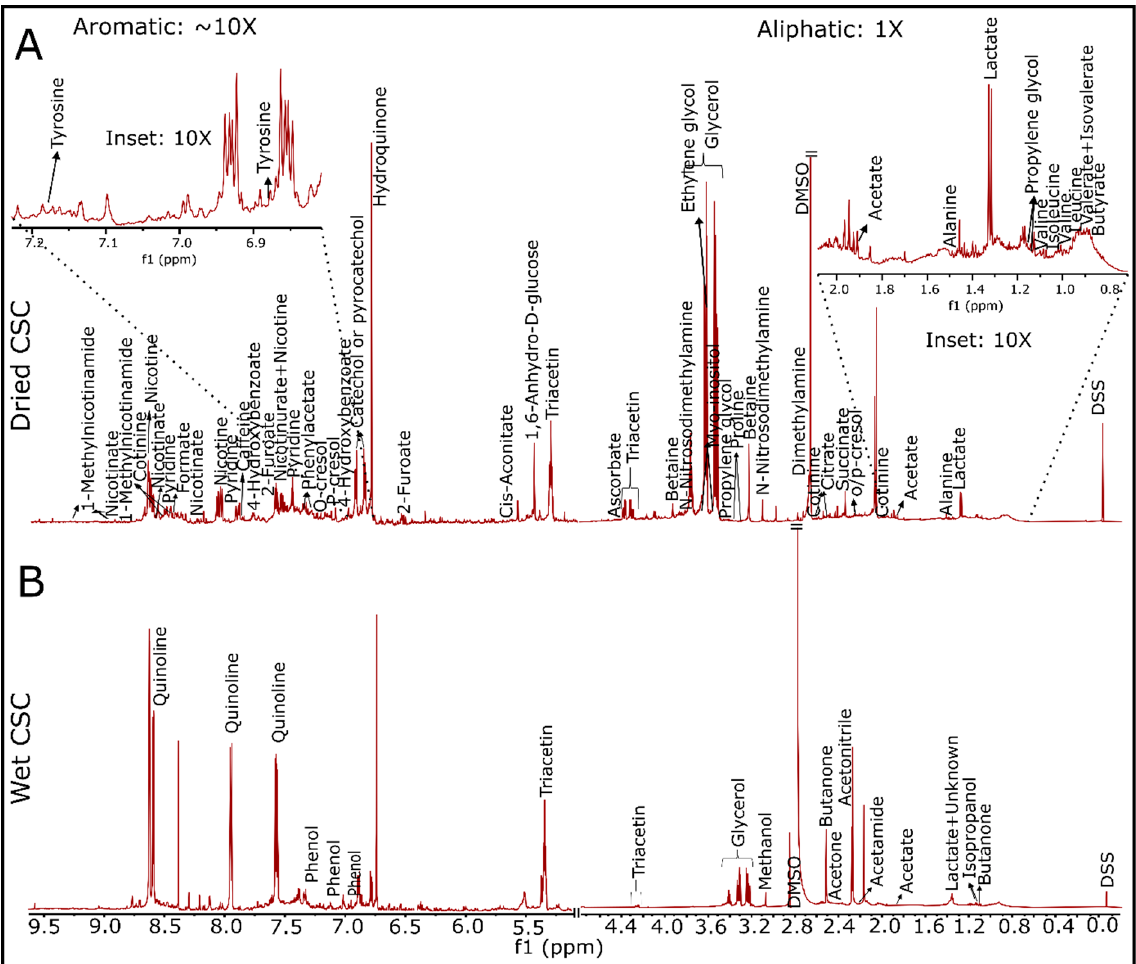
Figure 3. 1 H NMR spectra showing the water-soluble chemicals in 4% cigarette smoke condensate. A total of 49 chemicals were identified and annotated (listed in Supplementary Table S1) with the help of Chenomx NMR Suite 8.6, biological magnetic resonance bank (BMRB), and several published literatures. The upper spectrum showed all non-volatile water-soluble chemicals, while the bottom spectrum showed some volatile water-soluble chemicals. CSC: cigarette smoke condensate, DMSO: dimethyl sulfoxide.